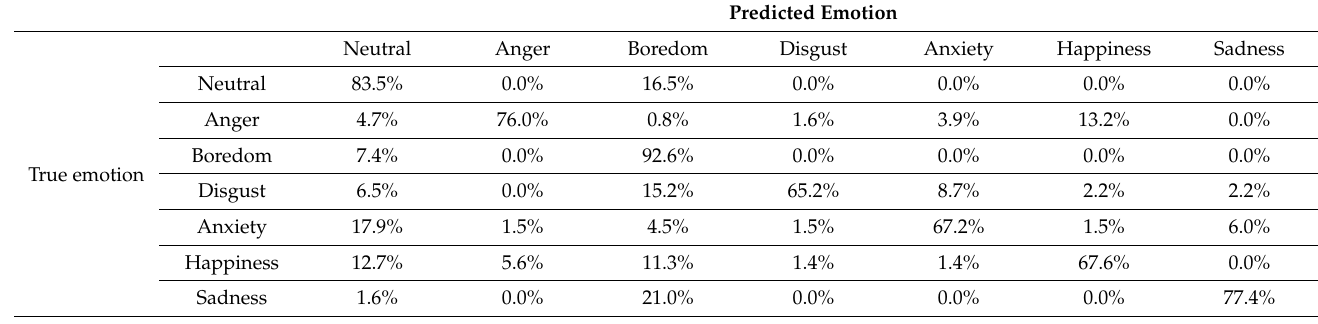
Table 11. Confusion matrix of the emotion classification results of the proposed cascaded DnCNN–CNN that was trained on the German EMO-DB mixed with the PCAFETER